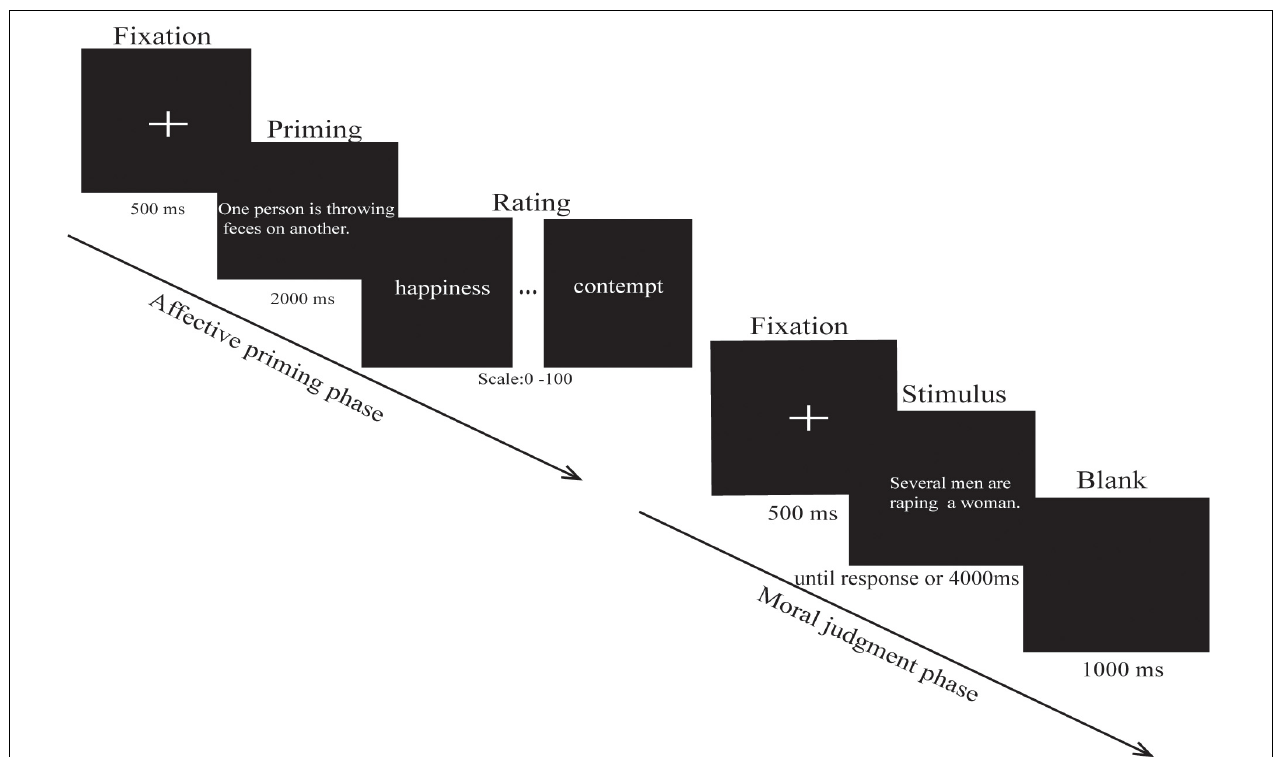
FIGURE 1 | Schematic representation of a single affective priming trial and a single moral judgment trial. The formal experiment consisted of three blocks; each block contained an affective priming phase and a moral judgment phase. (The original version of the images cannot be provided for copyright reasons, so we added a short textual description of what the image represented.) (Crone et al.,